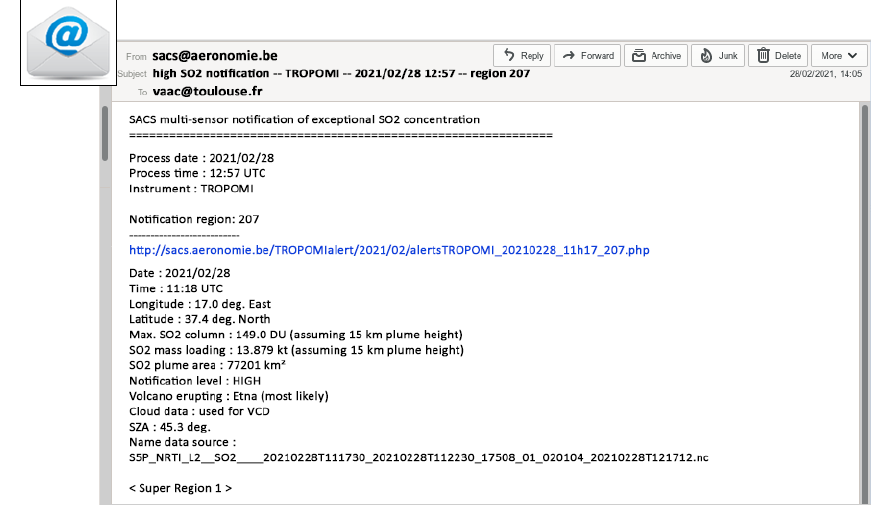
Figure 24. TROPOMI notification after a paroxysm from Etna on 28 February 2021. A link to an alert web page is provided (http://sacs. aeronomie.be/TROPOMIalert/2021/02/alertsTROPOMI_20210228_11h17_207.php, last access: 5 November